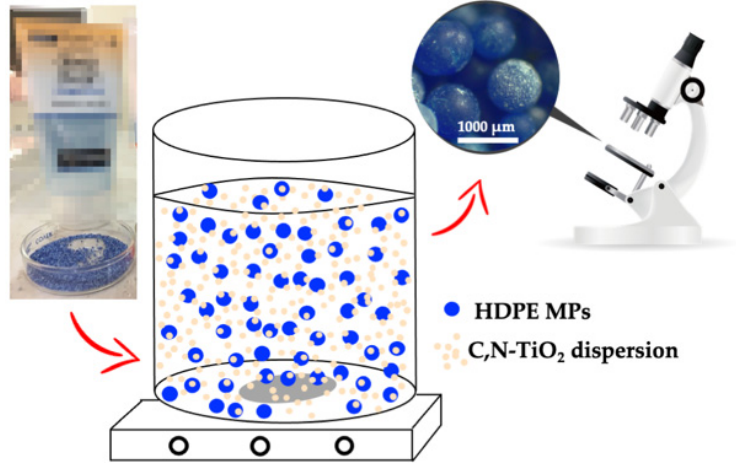
Figure 3. Adsorption of the C,N-TiO 2 semiconductor in the surface of HDPE MPs.